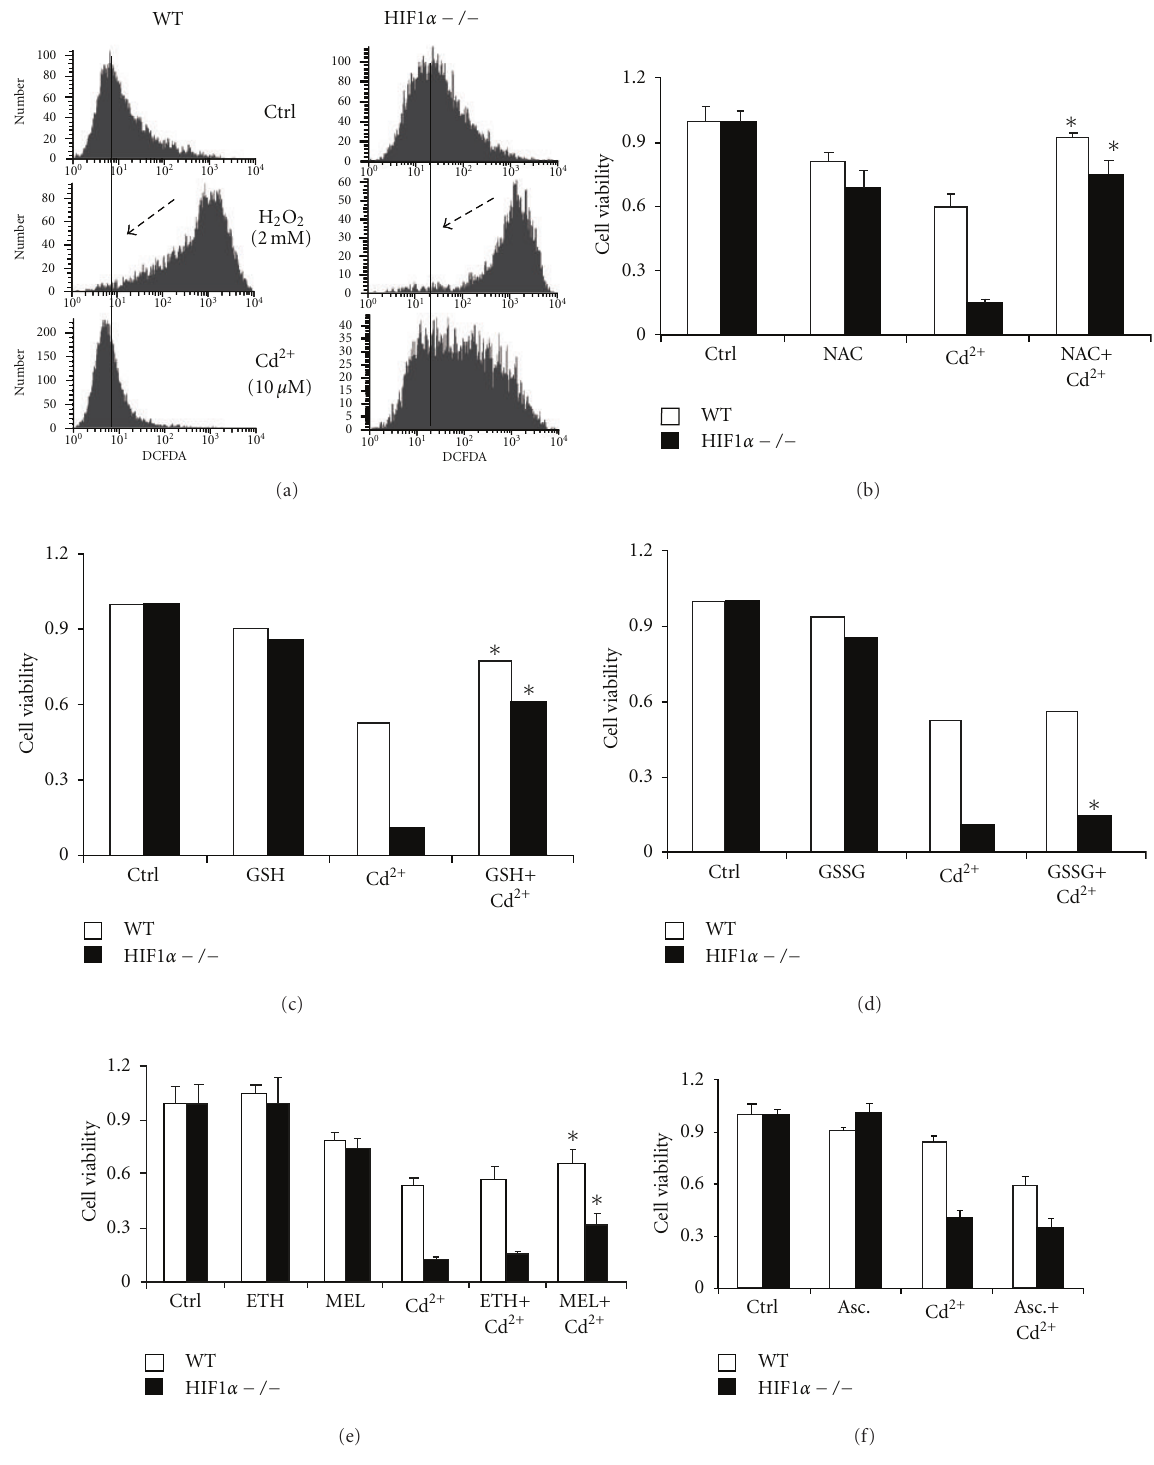
Figure 3: Oxidative Stress in CdCl 2 -mediated cytotoxicity. (a) Wild-type (WT) and HIF1 α − / − cells were left untreated (Ctrl), or exposed to 2mM H 2 O 2 (H 2 O 2 , 2 hours), or 10 μ M CdCl 2 (Cd 2+ , 24 hours). Reactive oxygen species generated in the cell were measured using the ROS-sensitive dye, CH-H 2 DCFDA, and flow cytometry. Arrow points to the median fluorescence intensity of control cells. (b) Wild-type (white bars) and HIF1 α − / − (black bars) cells were treated with 10 μ M CdCl 2 (Cd 2+ ) alone or with 10 mM N-acetyl cysteine (NAC) for 24 hours and cell viability was measured using MTT assay. (c)–(f) Wild-type (white bars) and HIF1 α − / − (black bars) cells were treated with 5 μ M CdCl 2 (Cd 2+ ) alone or with 1mM reduced glutathione (GSH, C), 1mM oxidized glutathione (GSSG, D), 0.5mM Melatonin (MEL, E), 0.2% ethanol (ETH, E) or 0.5mM ascorbic acid (Asc., F) and cell viability was measured using MTT assay. Control values within cell type were set to 1. ∗ significant compared to cadmium treatment within each cell type, P < 0 . 05, n >